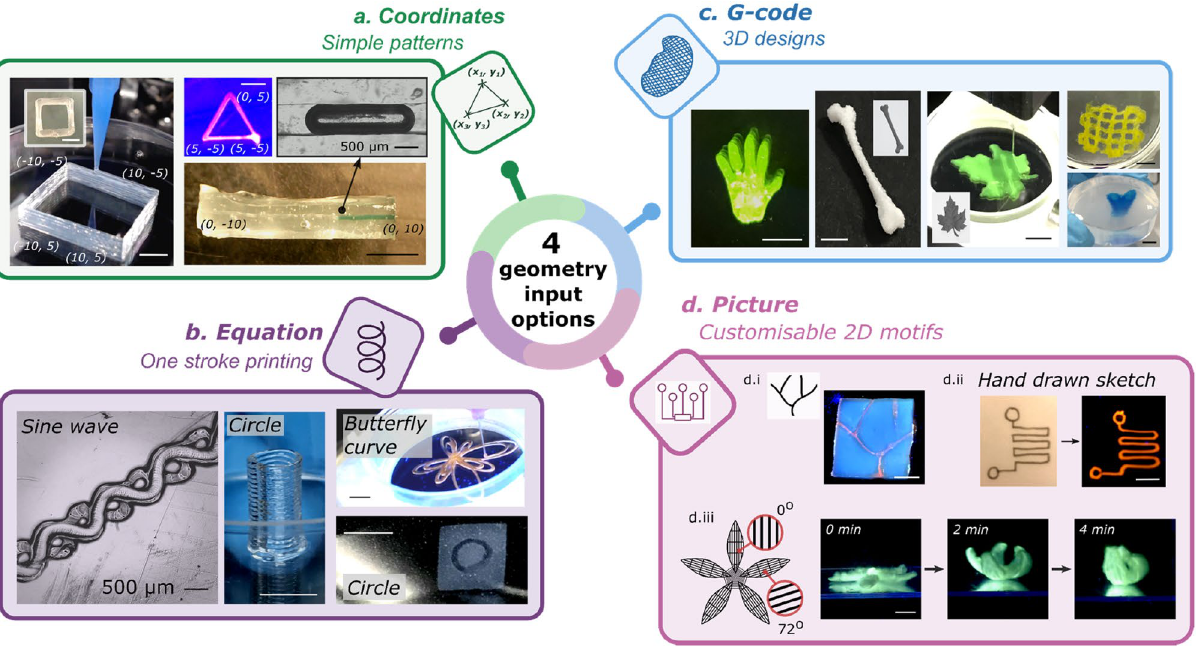
Figure 3. Versatile geometry input options enable creation of prints with different characteristics, via ( a ) coordinates, ( b ) equations, ( c ) CAD models which were then translated into G-code, and ( d ) picture geometries. The materials used here can be found in the Materials and Methods and Supplementary Table 6. Scale bars = 5